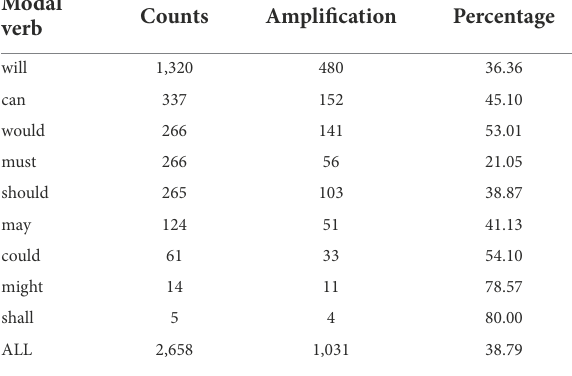
TABLE 9 Amplification used on each modal verb.